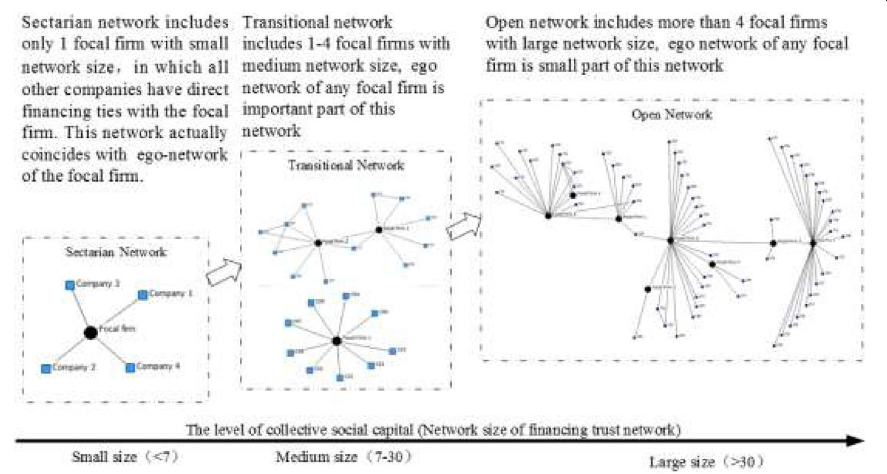
Fig. 2 Example of structures of three trust network